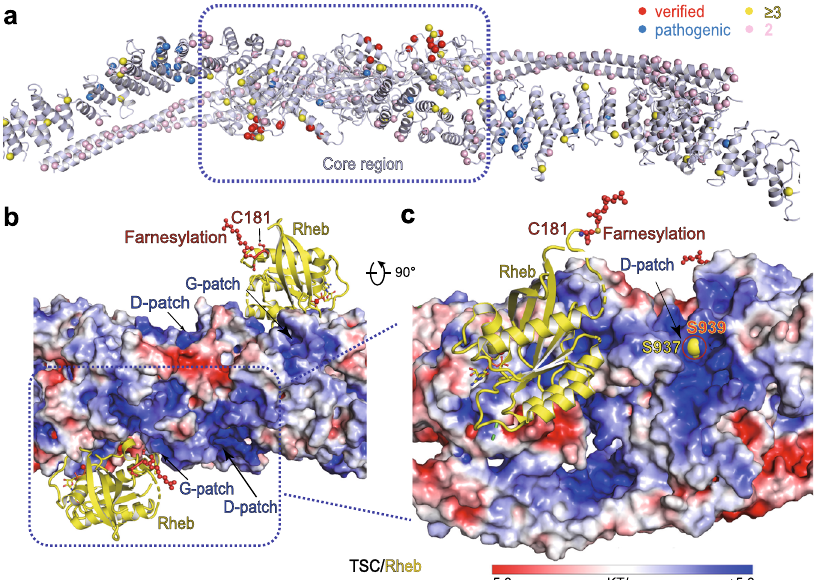
Fig. 4 TSC complex surface feature and functional implications. a The cartoon structure of TSC complex are shown with cancer-associated mutations highlighted with colored balls. The information of patient-derived mutations was obtained from the Catalogue of Somatic Mutations in Cancer (COSMIC) 33 . Critical residues for GAP activity that were veri fi ed in our study are shown as red balls, pathogenic mutations are shown as blue balls, and the mutations identi fi ed in patients ≥ 3 and 2 times in COSMIC database are shown as yellow and pink balls, respectively. b , c Electrostatic potential surface of TSC complex is shown in two views. Two putative Rheb molecules (yellow) are shown in cartoon with farnesylation at C181 (red) indicated ( b ). The traced residue S937 is shown in yellow balls. The positively charged patches around dimerization domain (D-patch) and GAP domain (G-patch) are shown in a close-up